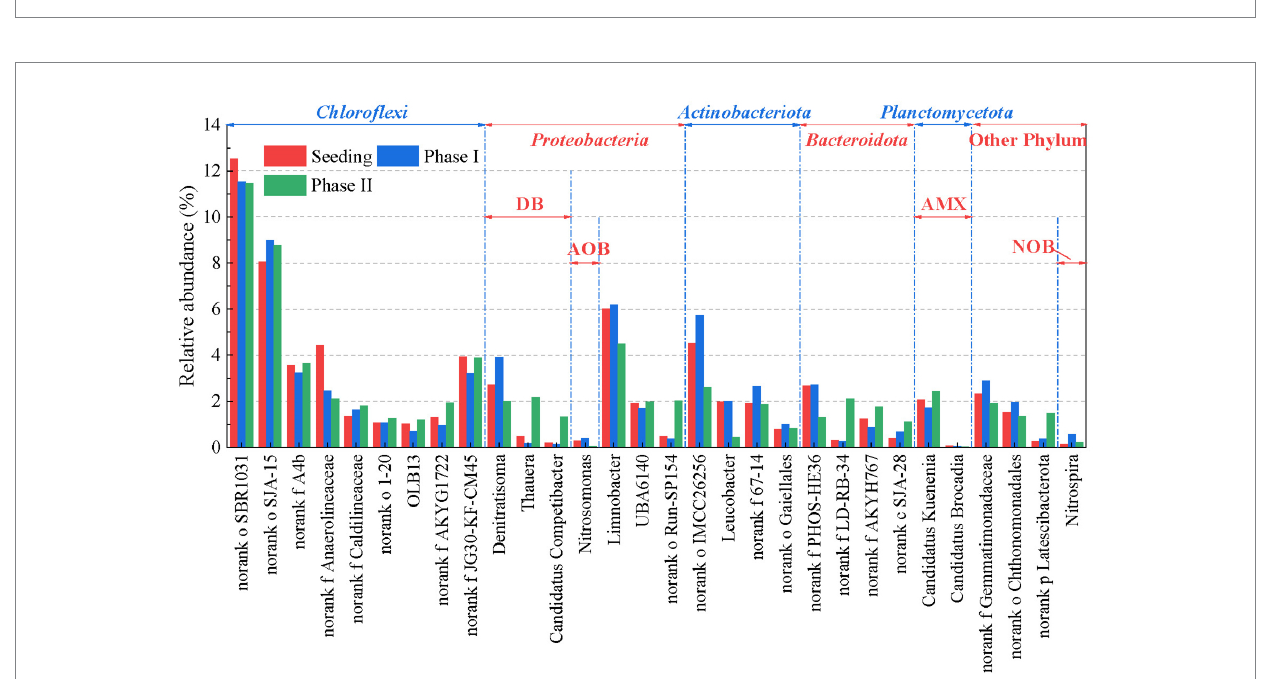
FIGURE 5 Variations in the microbial composition in the mainstream anammox